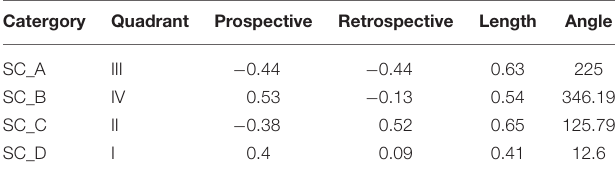
TABLE 8 | Polar coordinate analysis results showing the length and angle of the different vectors, the quadrant in which each vector is located, and the Z sum values (Cochran, 1954) from the prospective and retrospective